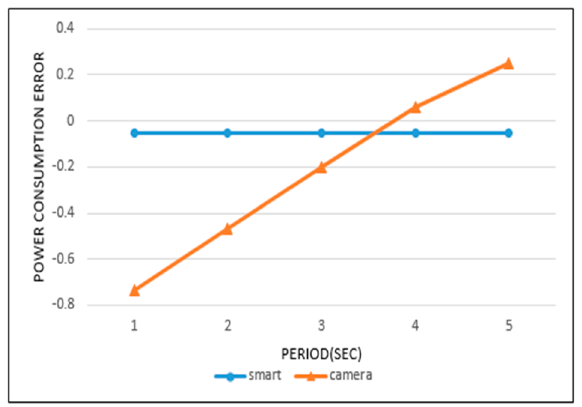
Figure 18. Power consumption error of camera sensor.